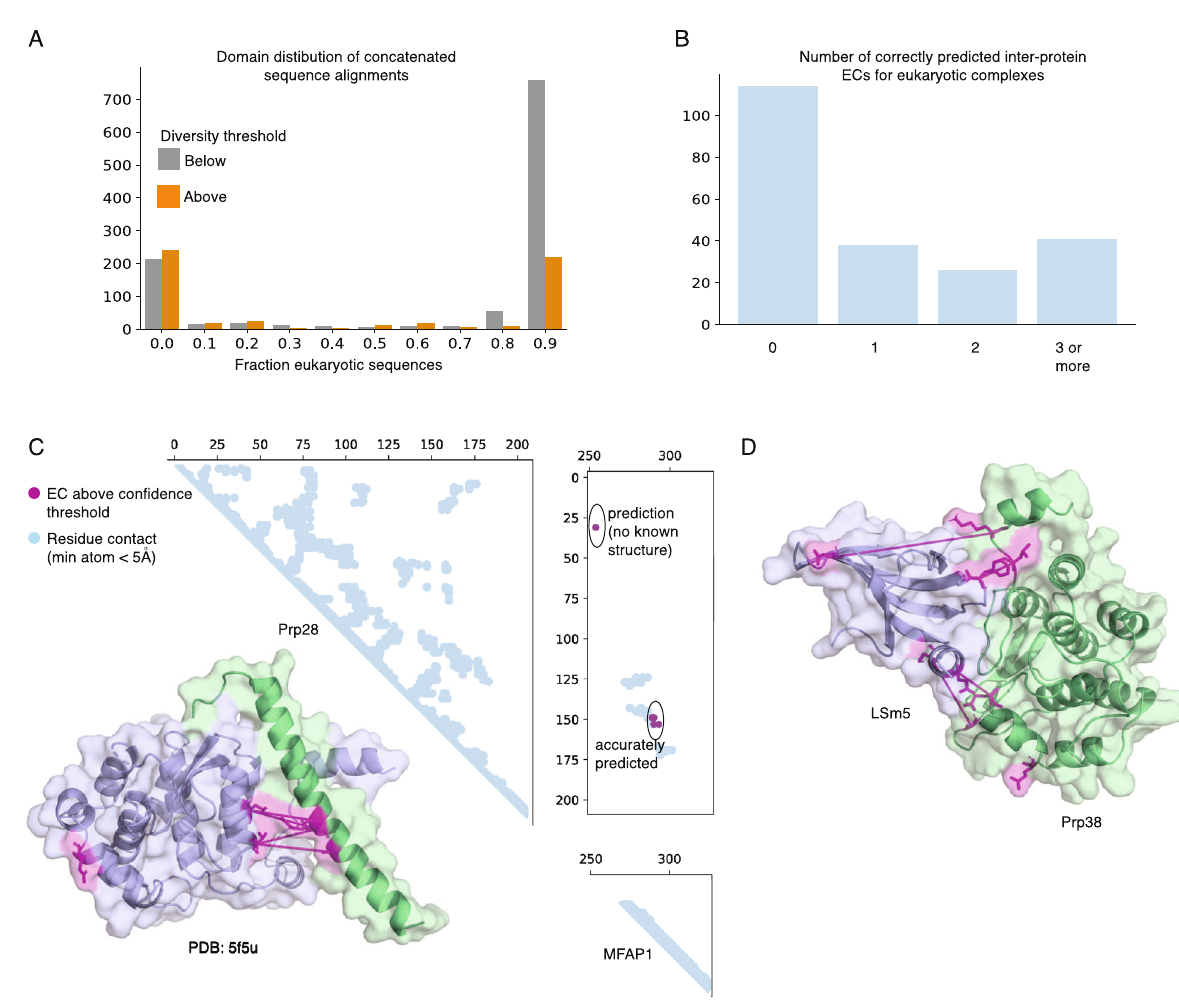
Fig. 6 Predicted protein interactions in eukaryotic proteomes. A Distribution of eukaryotic sequences in concatenated sequence alignments. Shown in orange are alignments that passed our sequence diversity threshold, and in gray are those that did not. B Number of correctly predicted inter-protein ECs for eukaryotic-exclusive complexes above the sequence diversity threshold. Eukaryotic-exclusive complexes are de fi ned as complexes whose concatenated sequence alignment is at least 90% eukaryotic sequences. Inter protein ECs are de fi ned as correct if their minimum atom distance is <8 Å. C The human spliceosome proteins Prp38 and MFAP1 have a known interface correctly predicted by our method, and have a protein interaction detected. The inter- protein ECs above the 80% precision threshold used throughout the paper are shown in purple. Known protein structure (PDB ID: 5F5U, [https://www. rcsb.org/structure/5F5U]) is used to visualize the subunits. D Schematic of predicted interaction between Lsm5 and Prp38 with top 5 inter-protein